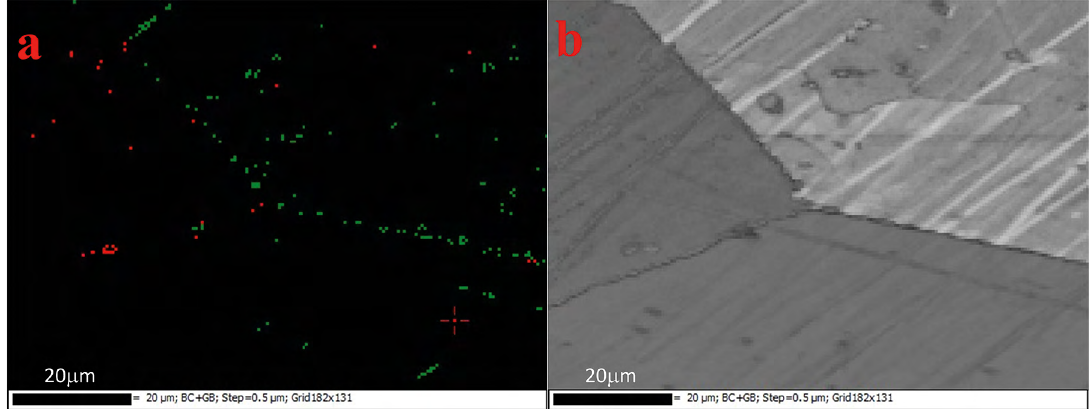
N (red points); (b) Band Contrast. 2